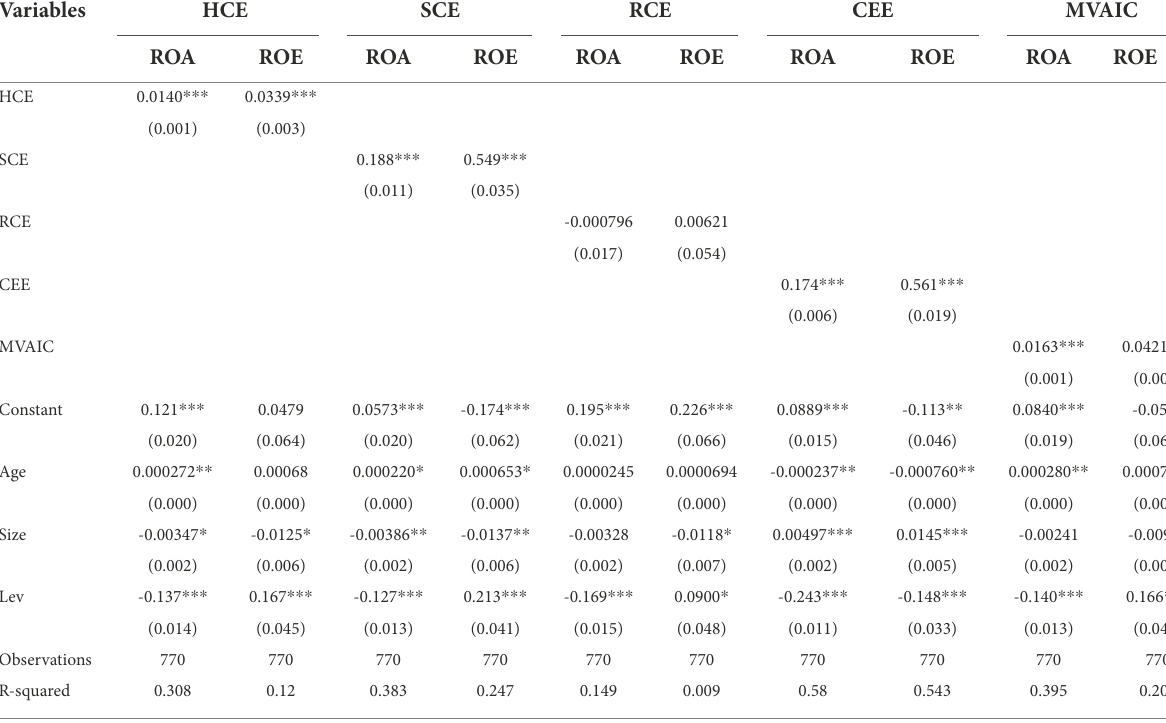
Table 4 Regression analysis of Pakistani firms.